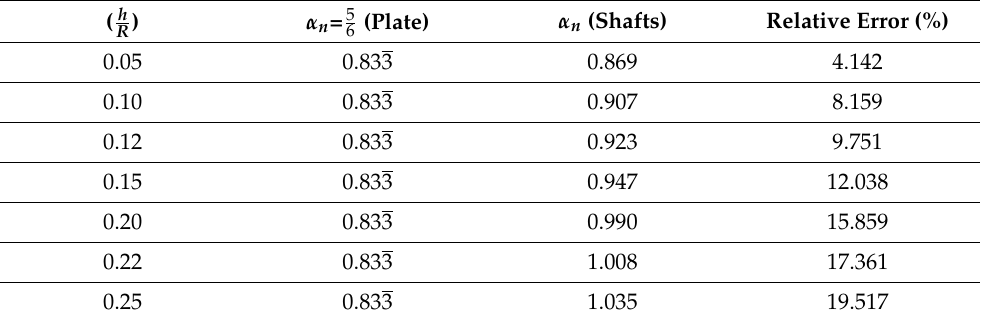
(cid:16) (cid:17) h . R